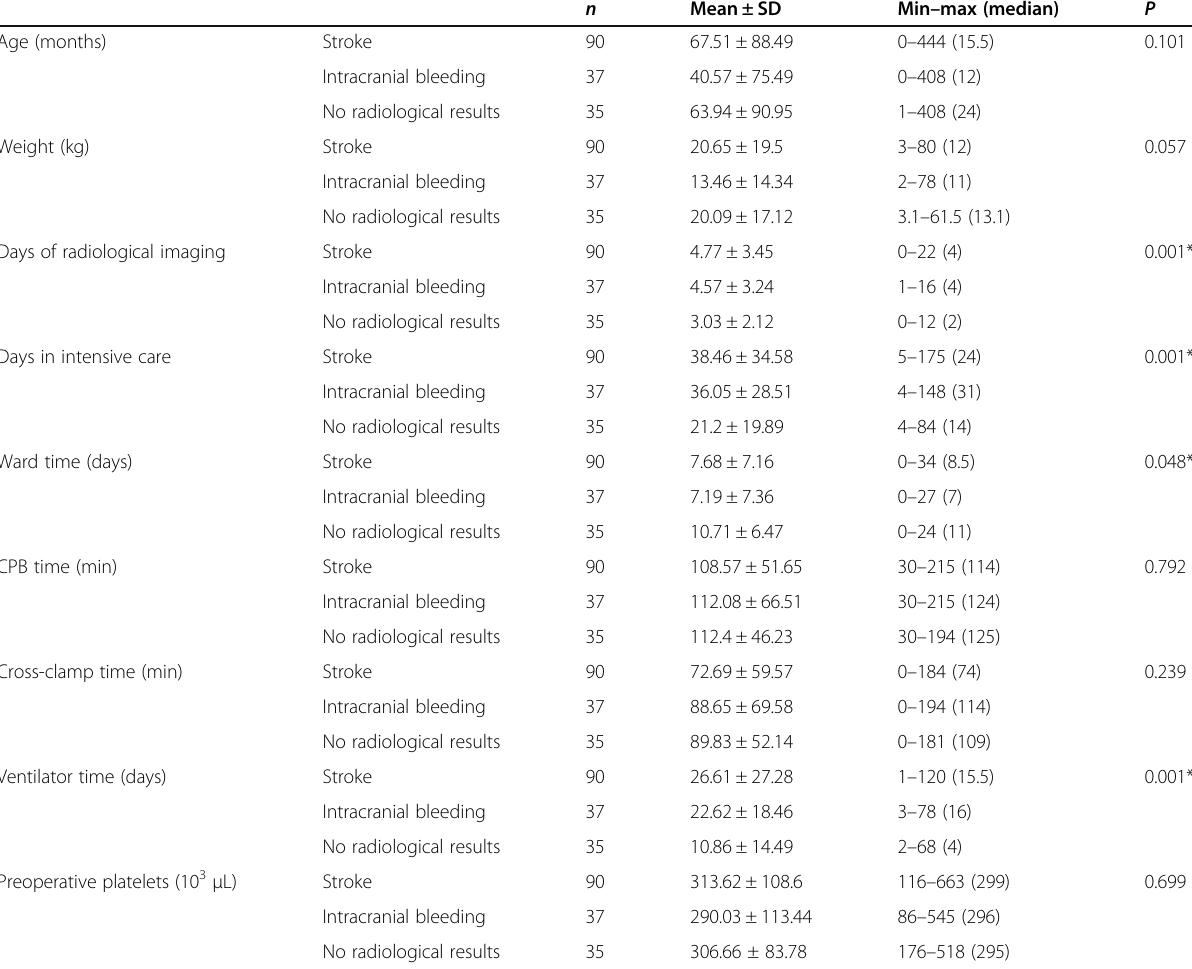
Table 3 Comparison of scales according to the stroke/intracranial bleeding/no radiological results groups n Mean ± SD Min – max (median)